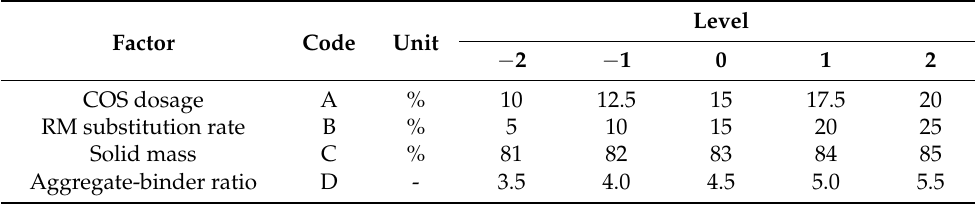
Table 2. CCD design